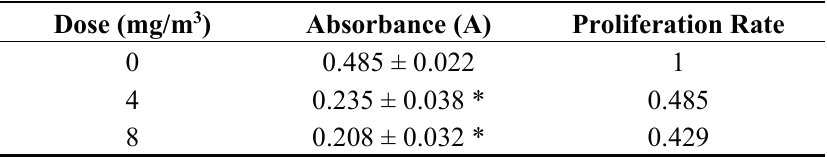
Table 1. T lymphocyte proliferation rates in spleen cells of FA exposed